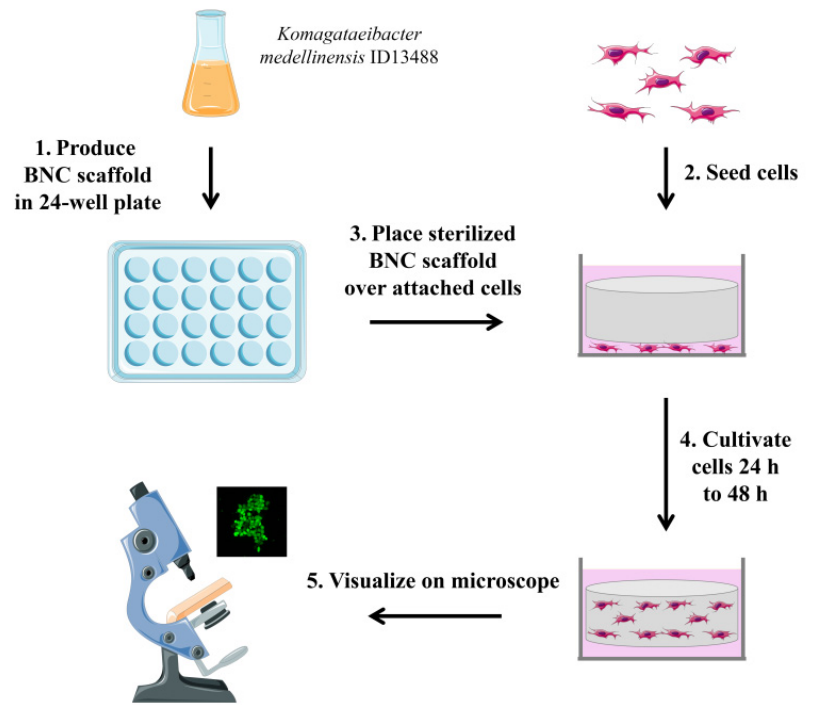
Figure 4. Schematic presentation of the developed in vitro cell migration assay based on bacterial nanocellulose. This figure was created with images adapted from Servier Medical ART (Servier, smart.servier.com (accessed on 20 June 2021), licensed under a Creative Commons Attribution 3.0 Unported License).